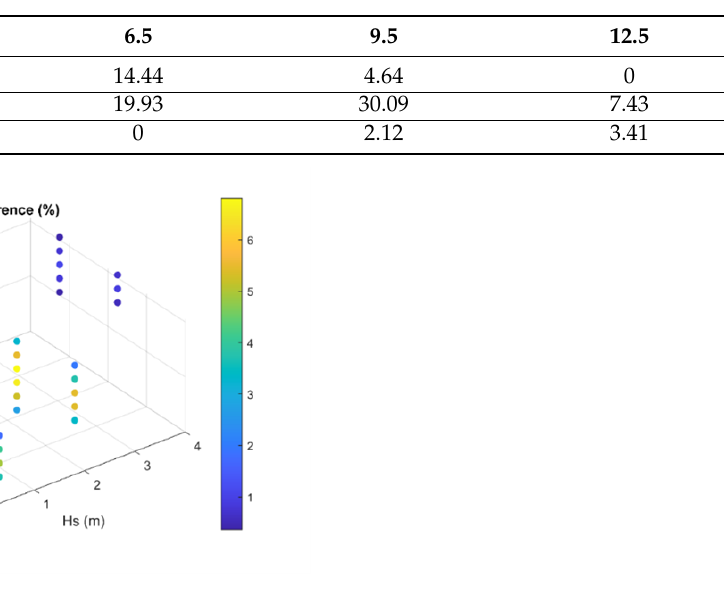
Figure 19. Filtered data set